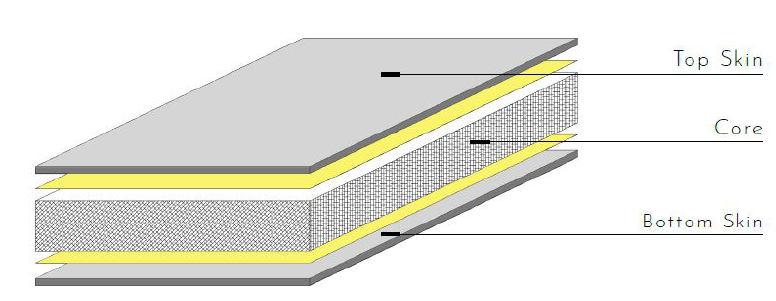
Fig. 1: Elements that comprise a sandwich panel